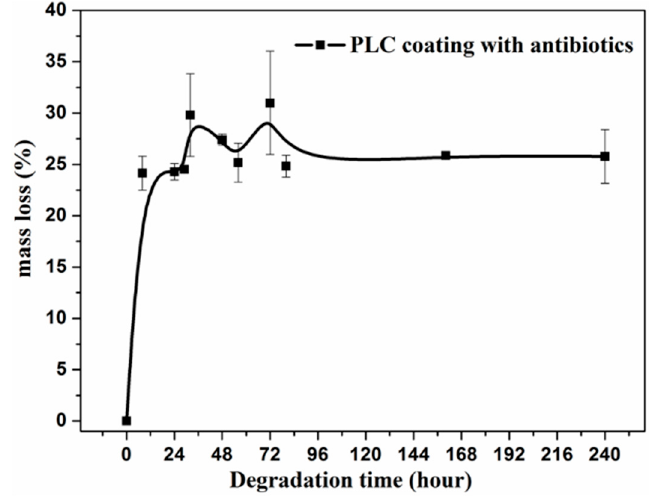
Figure 7. The mass loss of the PLC coatings with antibiotics over time.